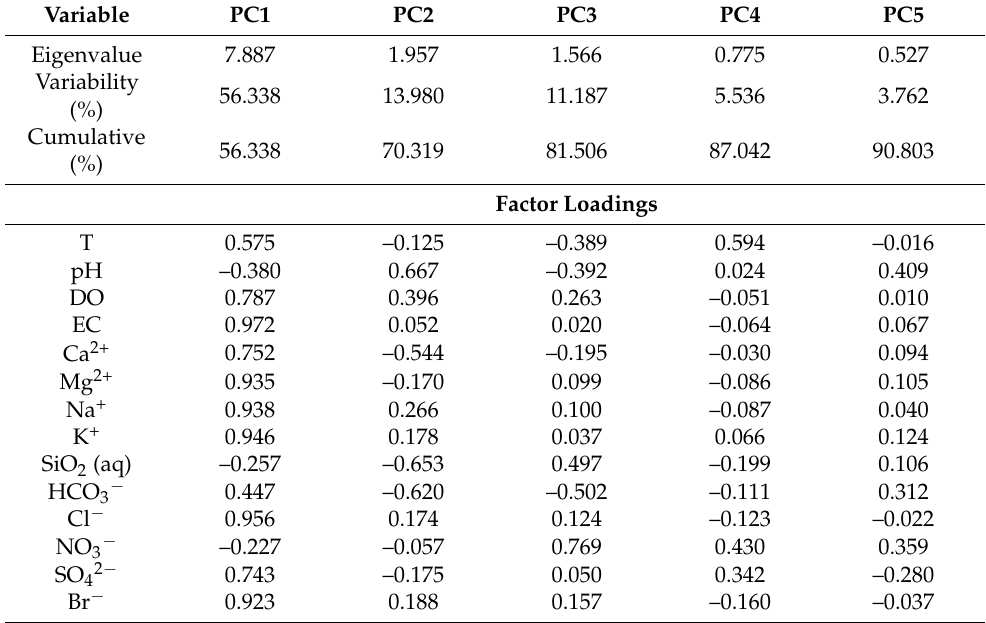
Table 6. Principal component loadings, eigenvalues, and explained variance for five extracted components of groundwater